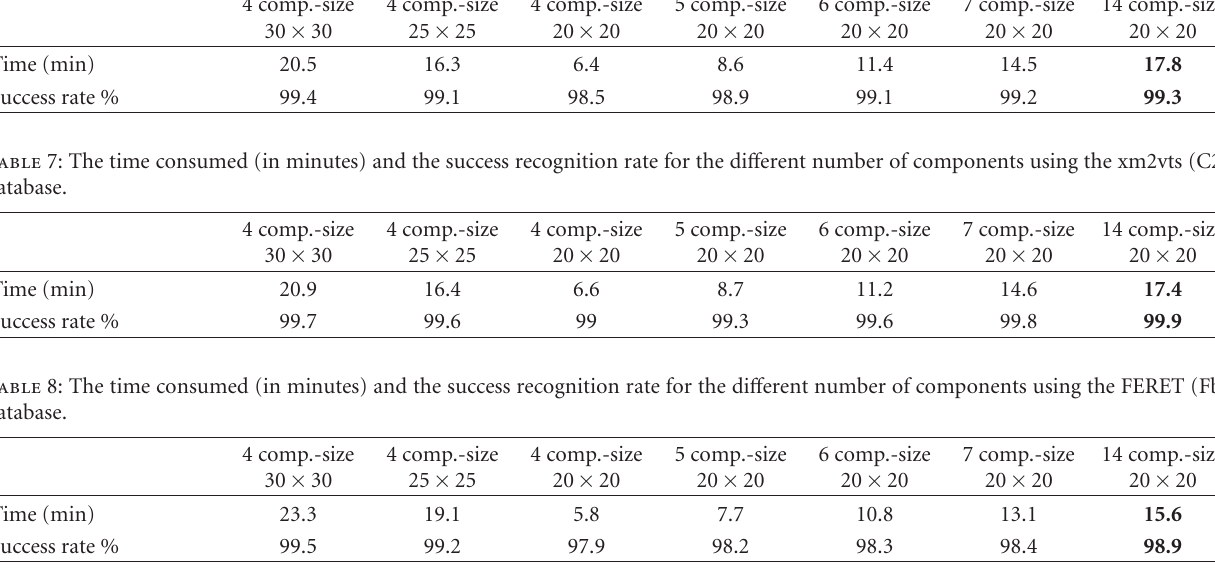
Table 5: The time consumed (in minutes) and the success recognition rate for the di ff erent number of components using the ORL database. 4 comp.-size Time (min) Success rate % Table 6: The time consumed (in minutes) and the success recognition rate for the di ff erent number of components using the xm2vts (C1) database. 4 comp.-size Time (min)